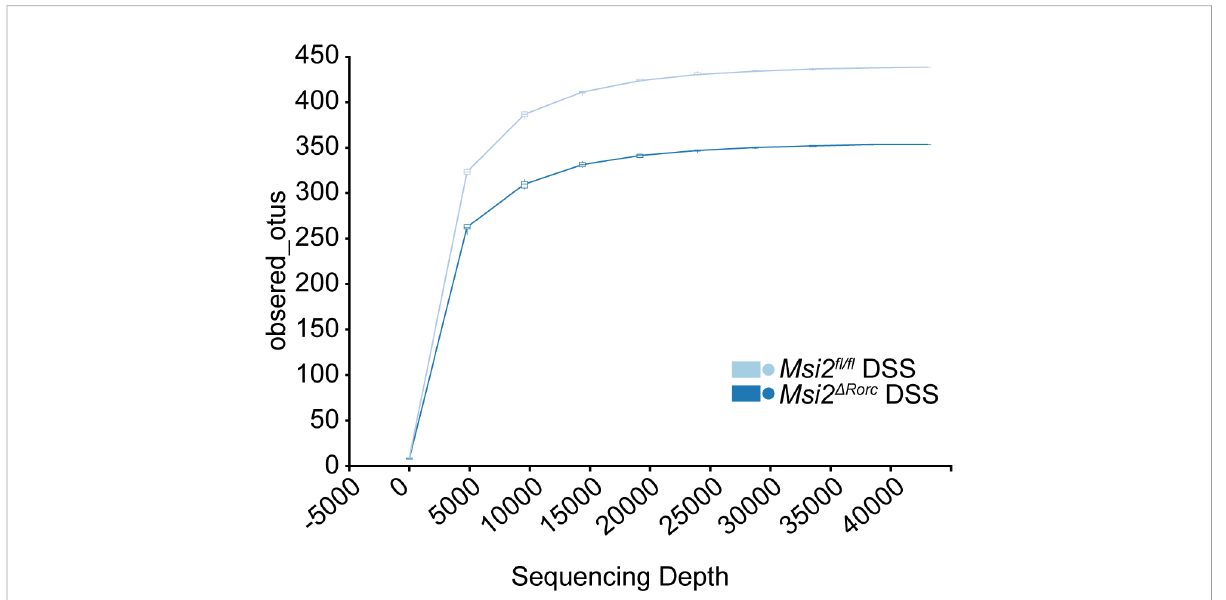
FIGURE 4 The rarefaction curve for community richness showed that a suf fi cient sequencing depth was reached